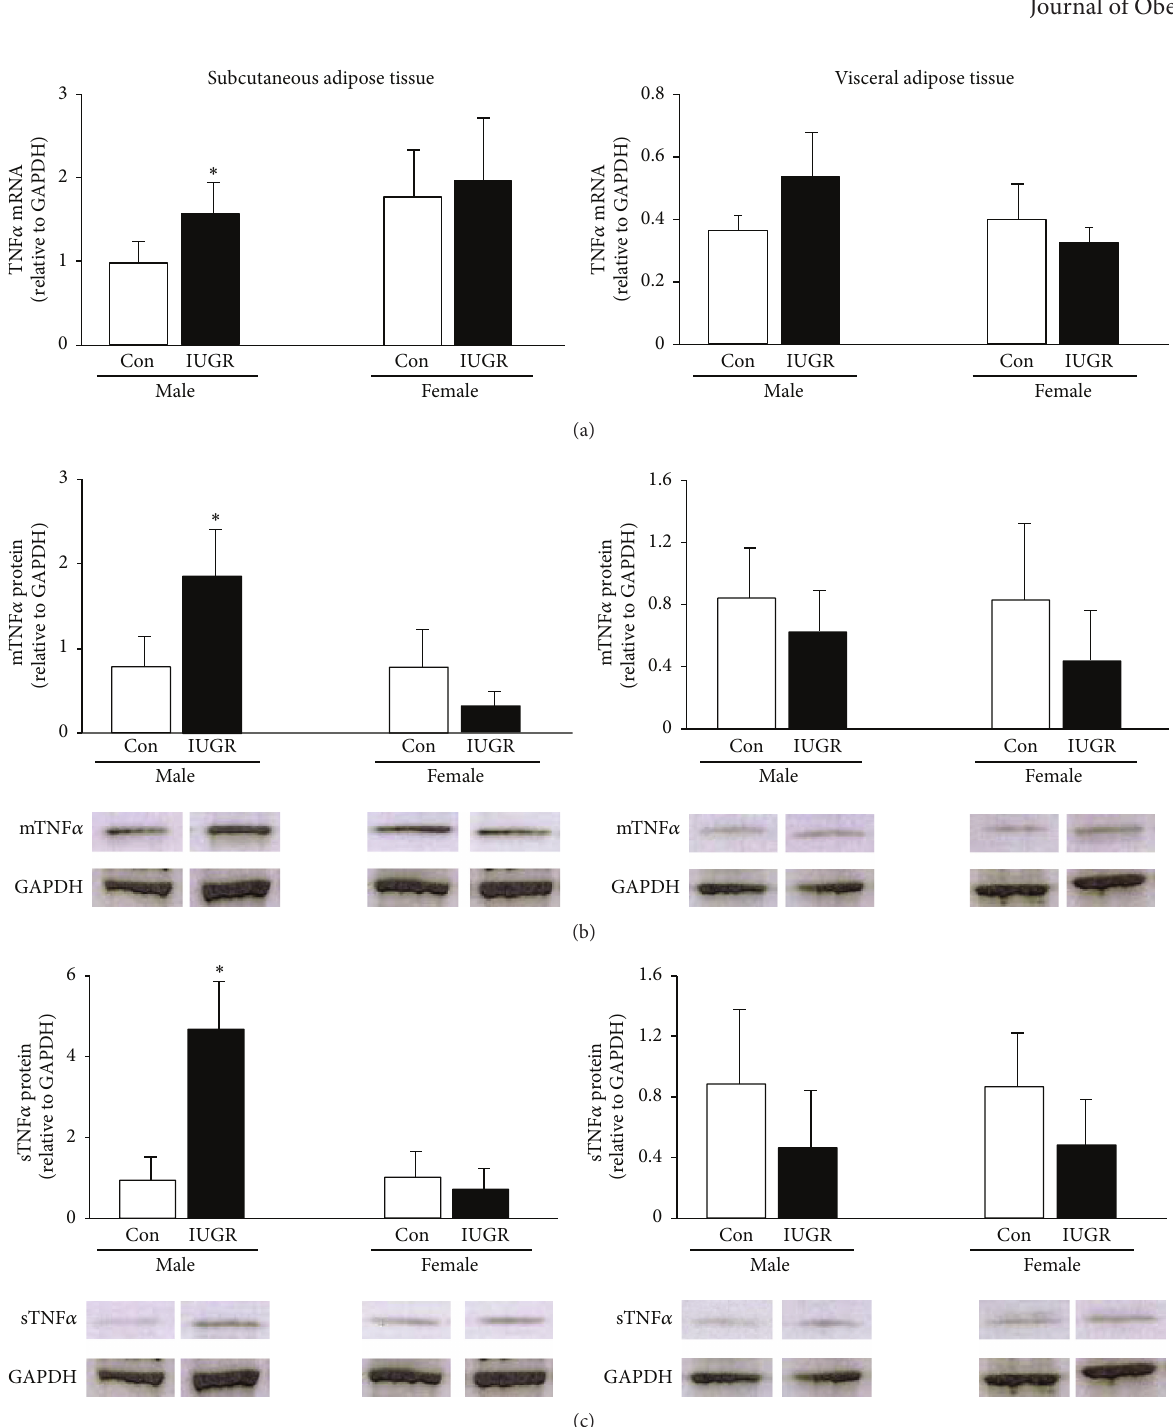
adipose depot and sex-specific manner prior to the onset of obesity and impaired glucose tolerance. The majority of molecular effects were confined to the SAT of male rat pups, with female rat pups being relatively unaffected.